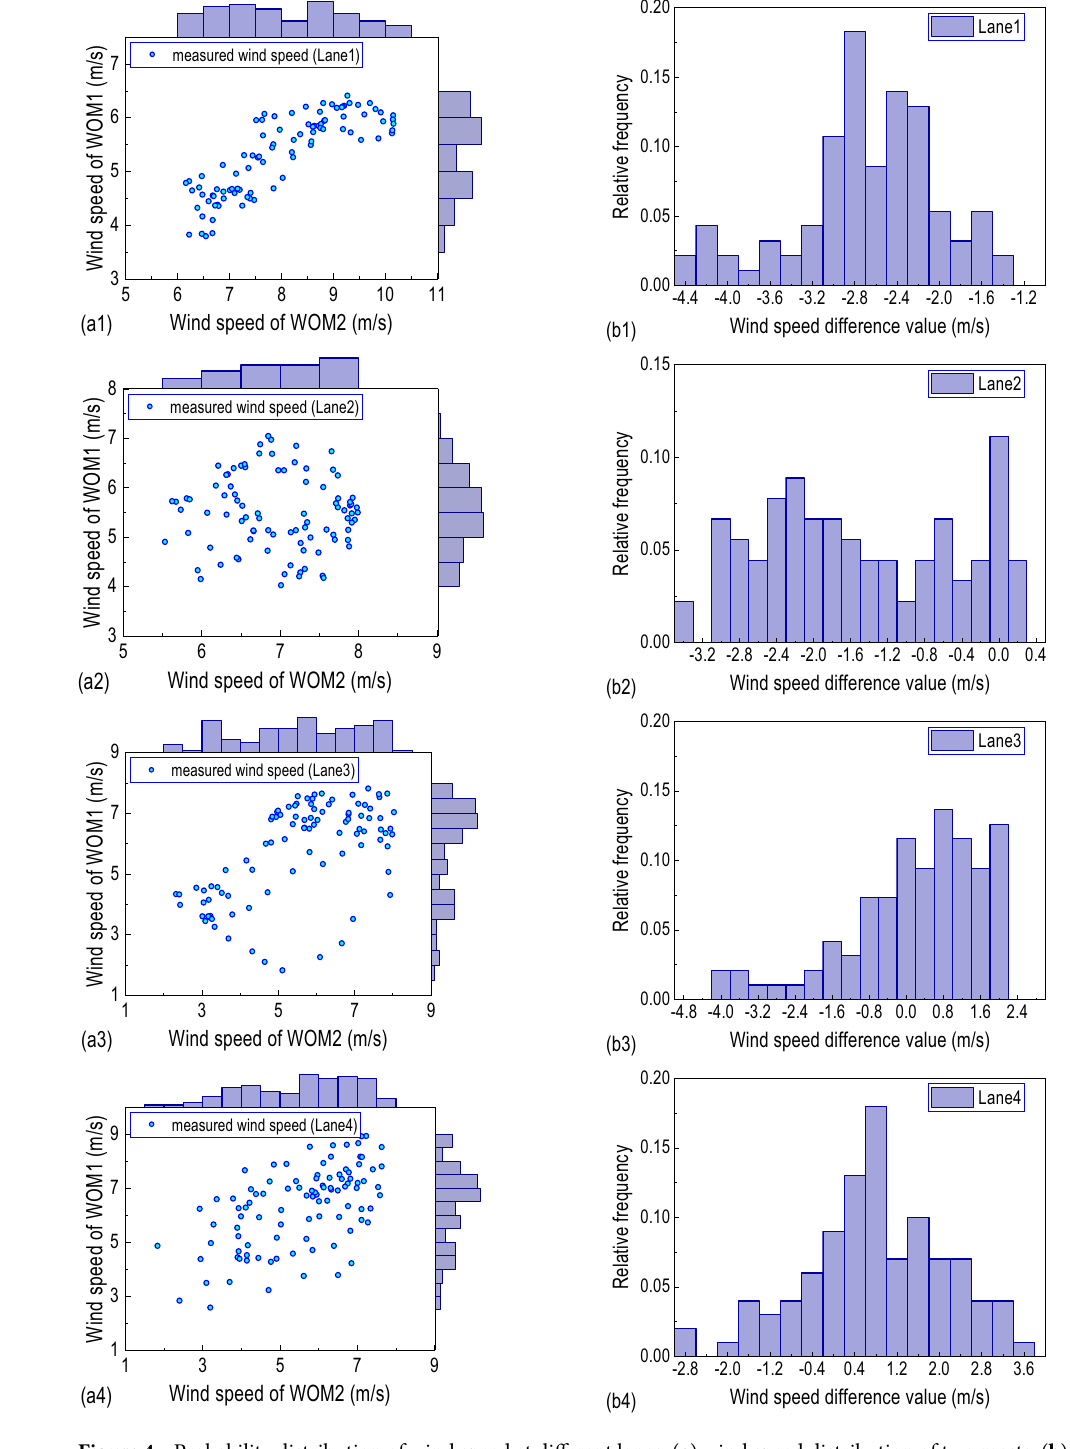
Figure 4. Probability distribution of wind speed at different lanes: ( a ) wind speed distribution of two masts; ( b ) wind speed difference probability distribution between two masts; (1) Lane 1, (2) Lane 2, (3) Lane 3, (4), Lane